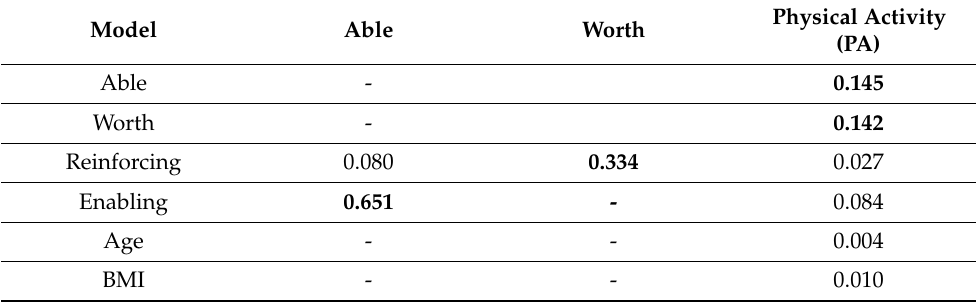
Table 6. Effect sizes of the direct effects—actionable predictors of physical activity.